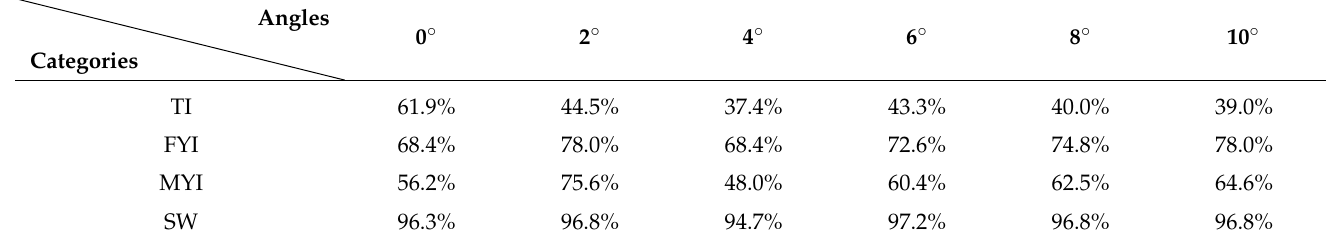
Table 6. Highest F1 scores of sea ice types and sea water at small incidence angles.